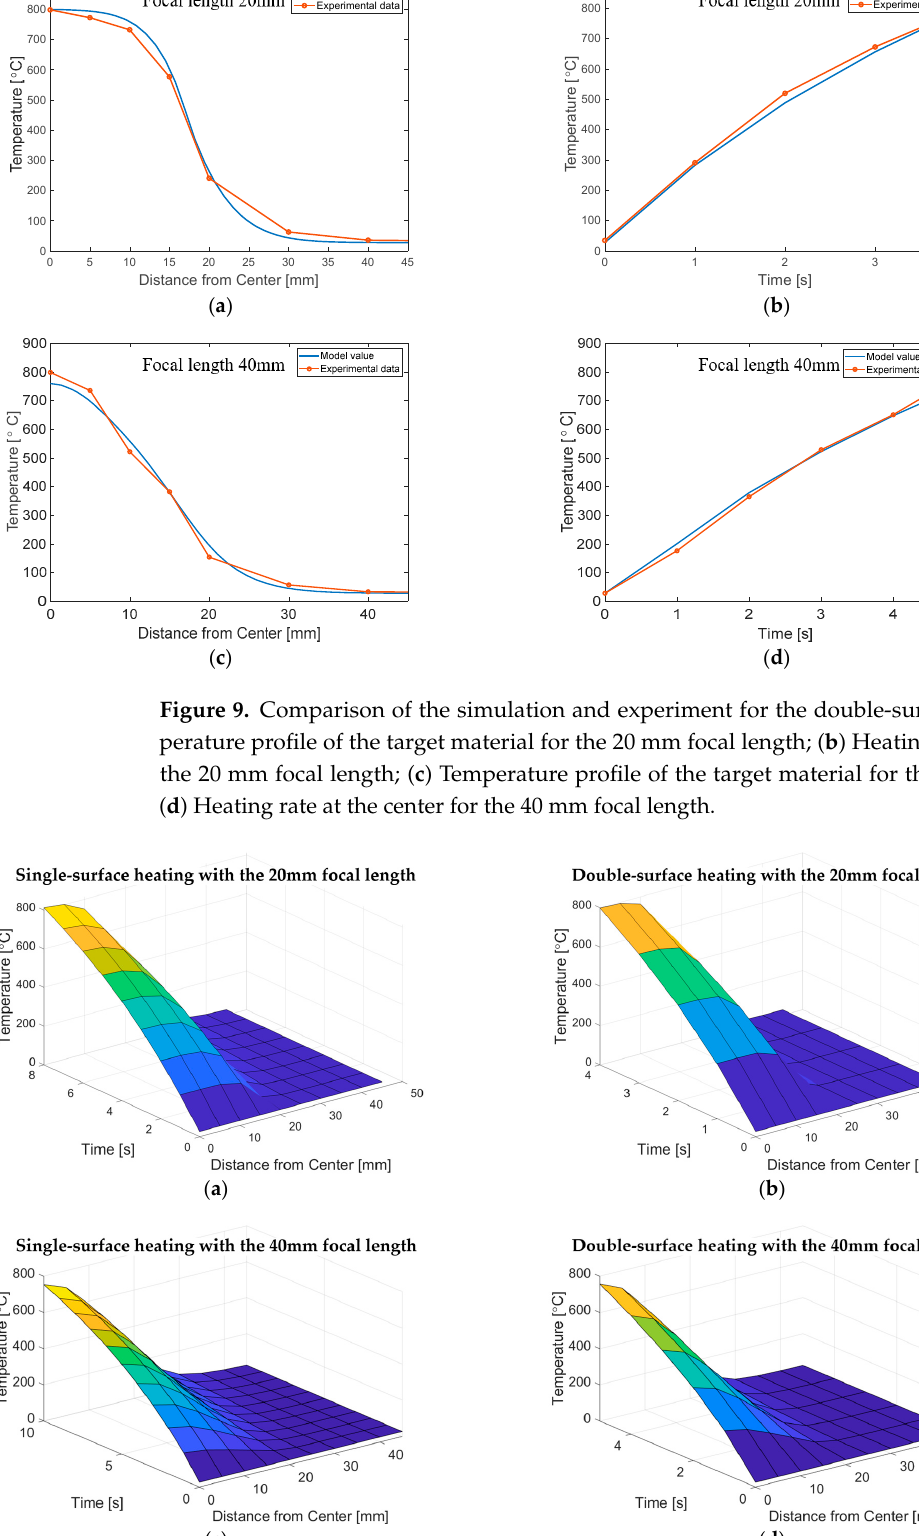
Figure 10. Temperature surface with respect to position and time: ( a ) Single-surface heating with the 20 mm focal length; ( b ) Double-surface heating with the 20 mm focal length; ( c ) Single-surface heating with the 40 mm focal length; and ( d ) Double-surface heating with the 40 mm focal length.